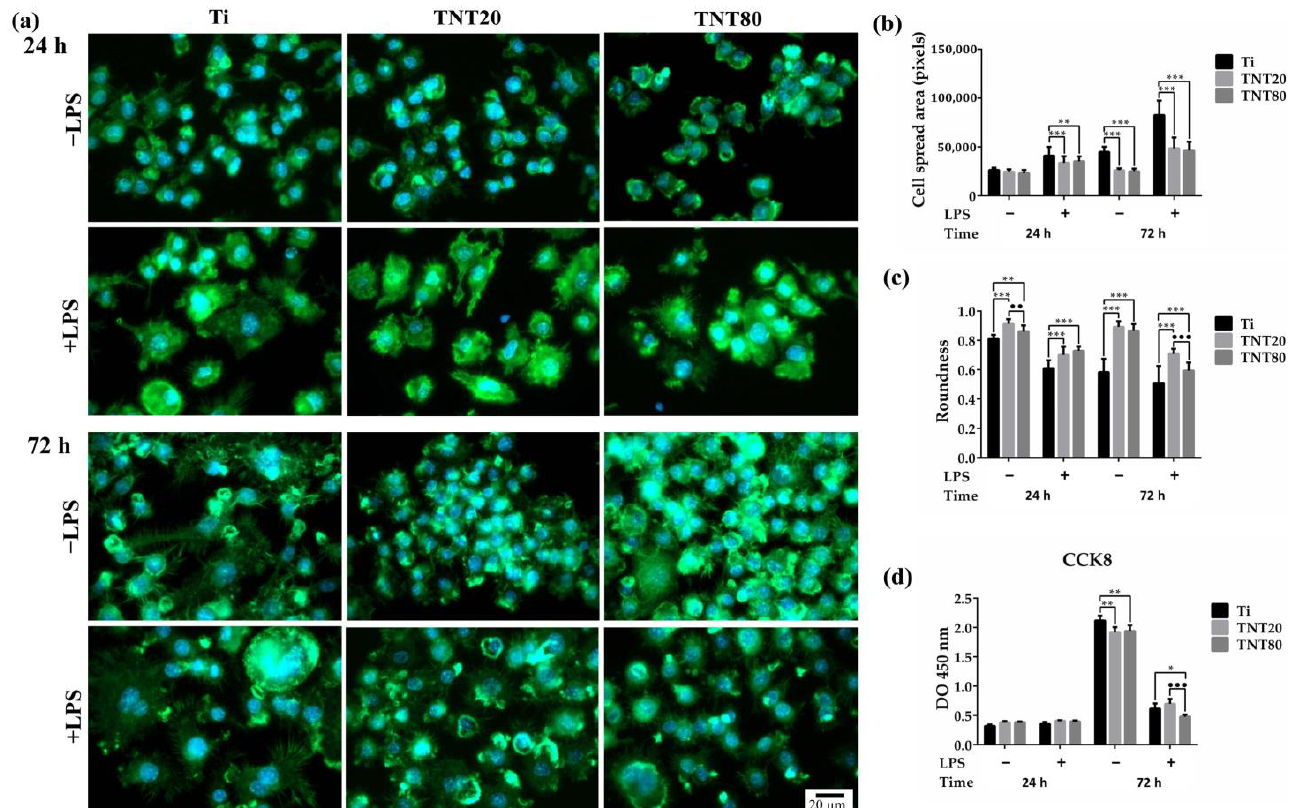
Figure 3. The morphological behavior and proliferation rate of RAW 264.7 cells maintained in contact with the tested surfaces for 24 h and 72 h, under standard ( − LPS) and pro-inflammatory conditions (+LPS). ( a ) Macrophage morphology was evaluated by actin staining with phalloidin coupled with Alexa Fluor 488 (green fluorescence) which revealed differences in the actin cytoskeleton organization and morphological alterations under LPS stimulation. Nuclei were counterstained with DAPI (blue fluorescence). All images were captured at the same magnification (scale bar represents 20 µm). ( b ) Quantification of cell roundness. Results are expressed as means ± SD (n = 30 cells, ** p < 0.01, *** p < 0.001 vs. Ti, •• p < 0.01, ••• p < 0.001 vs. TNT20). ( c ) Quantification of cell spread area. Results are presented as means ± SD ( n = 30 cells, ** p < 0.05, *** p < 0.001 vs. Ti). ( d ) RAW 264.7 cells proliferation as assessed by the CCK-8 assay ( n = 3, mean ± SD, * p < 0.05, ** p < 0.01 vs. Ti, ••• p < 0.001 vs. TNT20).